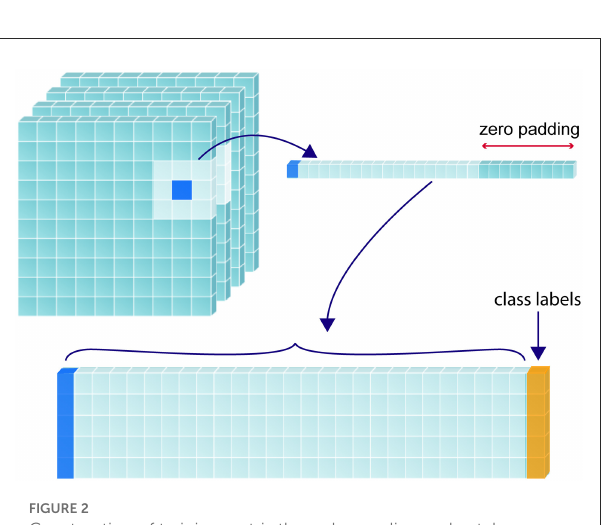
FIGURE2 Construction of training matrix through sampling and patch extraction. For a given randomly selected sample (shown in dark blue), its corresponding perfusion map value/s and the values corresponding to its 26 immediate neighbors are collapsed into a 1-dimensional array, with the corresponding class label (yellow) added at the furthermost right position. If multiple perfusion maps are used, the 27 values from each map are recursively added to extend the 1-D array to the left of the class label. The 1-D array for each label are stacked to form a 2-D training